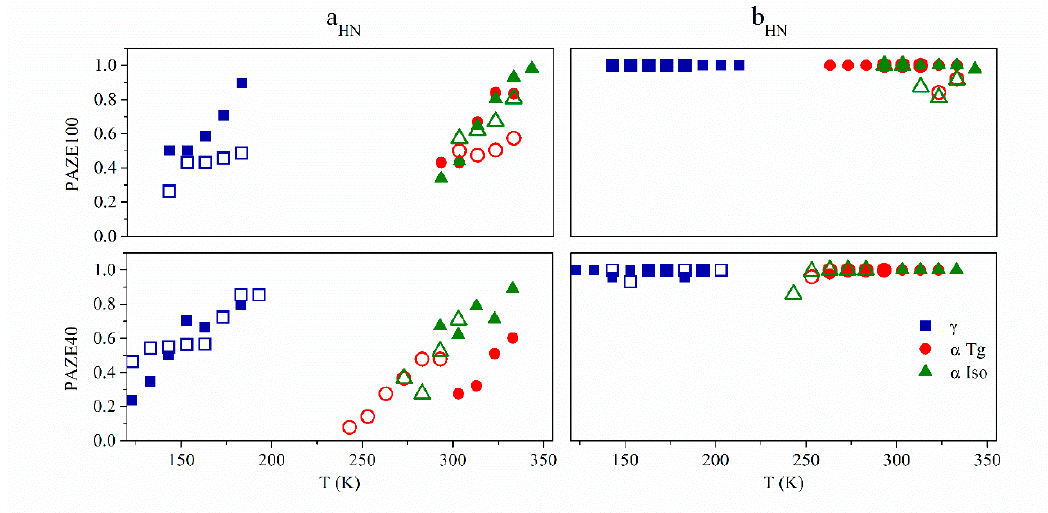
Figure 11. Detail of the Havriliak–Negami parameters a HN and b HN for the PAZE100 and PAZE40 for the γ , α Tg and α Clear relaxations of the unoriented (hollow symbols) and oriented (full symbols) copolymers.